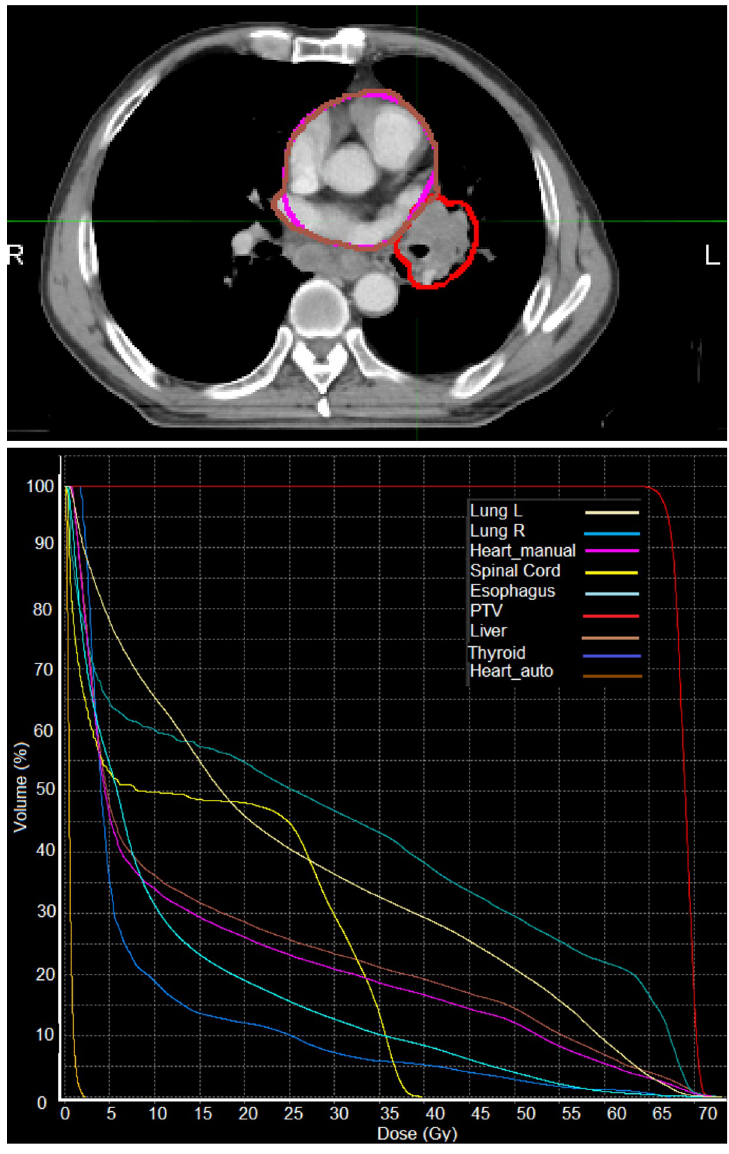
Fig 6. A demonstration of an evaluation of the dosimetric impact of using the automatic heart segmentation (Heart_auto, brown) relative to the clinical heart contour (Heart_manual, pink). We observe a higher overall dose to the automatically defined volume, which was generated as the union of delineations on each individual binned respiratory phase from the 4D-CT image. Top: contours for the heart and tumour (red) shown in an axial slice on the maximum intensity CT image, bottom: a dose-volume histogram for the planning target volume (PTV) and several organs at risk.